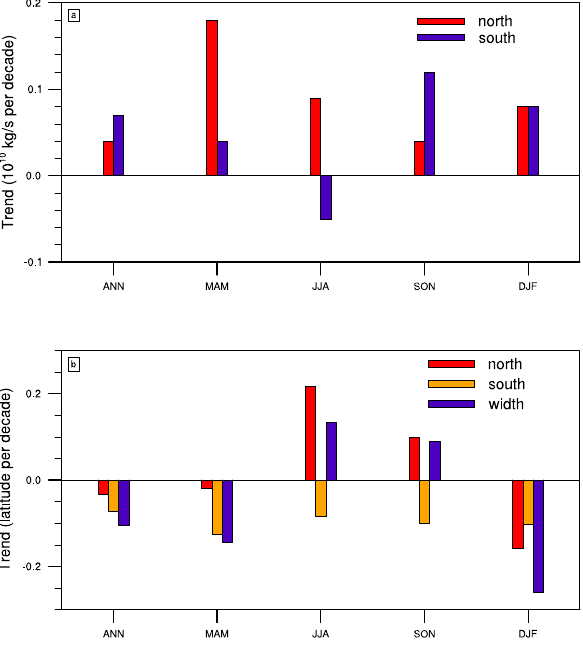
Fig. 3. Annual and seasonal trends of (a) the strength of the northern and southern Hadley Circulation ( × 10 10 kgs − 1 per decade), and (b) the poleward-edge and width of the Hadley Circulation (latitude per decade) for